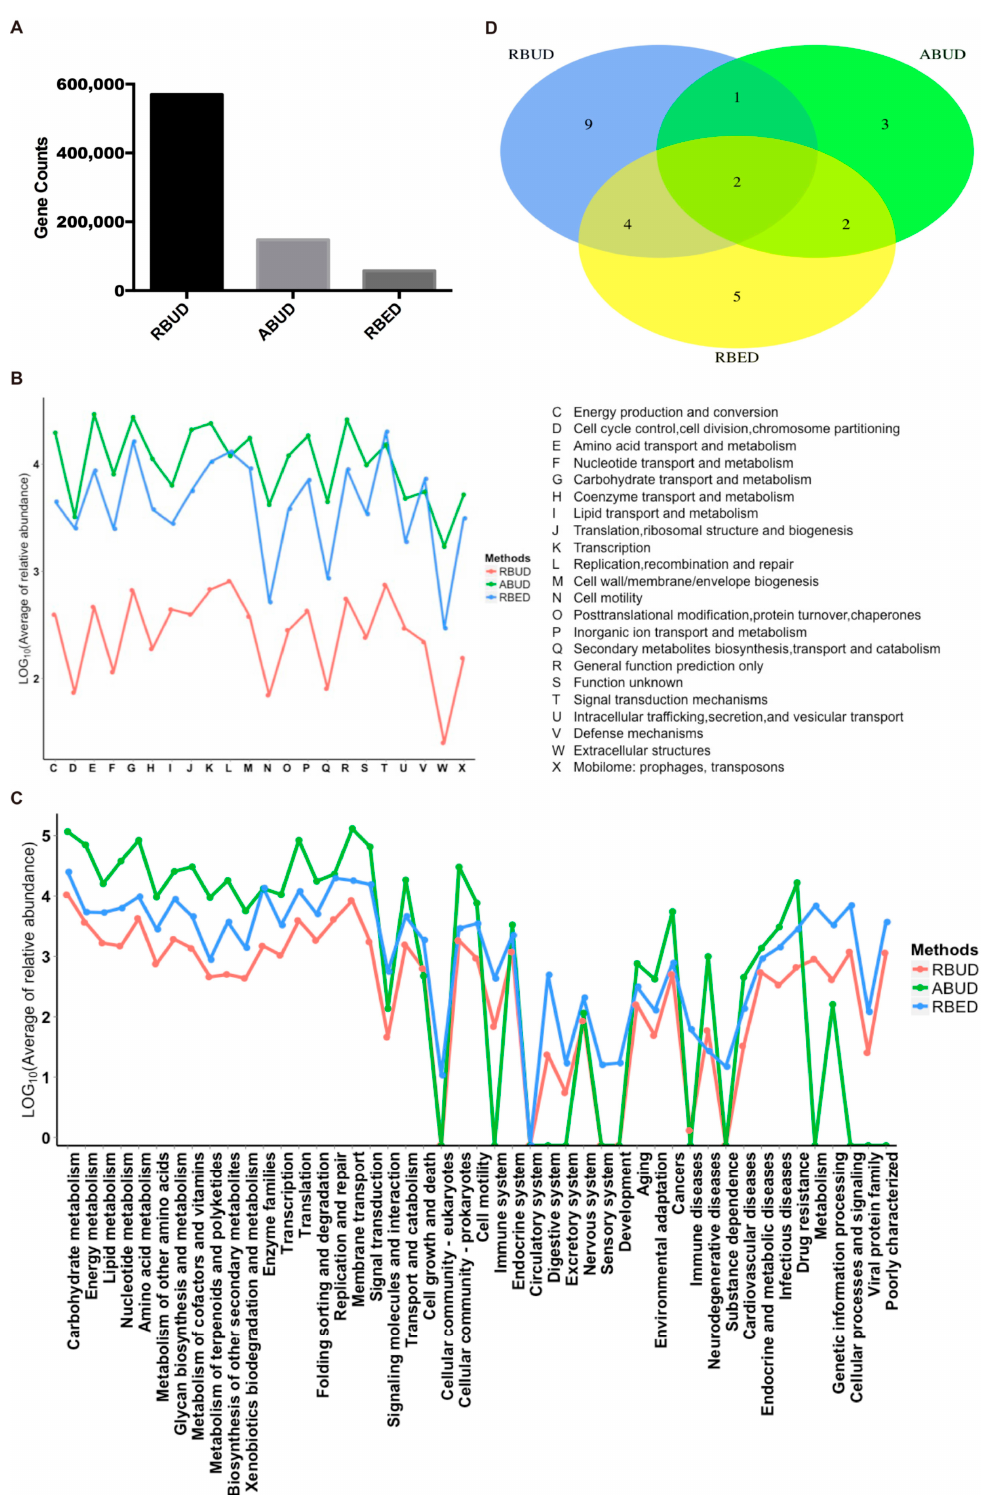
Figure 3. The comparative analysis of the enriched functions using the three methods in the case study of T2D. ( A ) The comparison of enriched gene counts using the three methods. ( B ) The relative abundance trend of functions in categories of Cluster of Orthologous Group of Proteins (COG) using di ff erent methods. ( C ) The relative abundance trend of functions in categories of Kyoto Encyclopedia of Genes and Genomes (KEGG) using di ff erent methods. ( D ) Venn diagram showed the overlap of KEGG functional modules that enriched by di ff erent